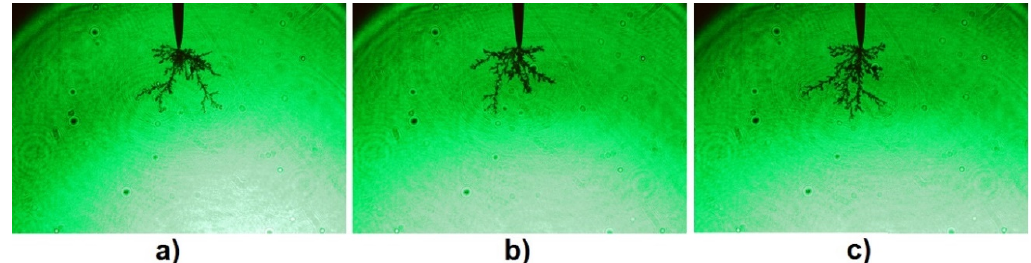
Figure 5. Photographs of negative streamers in: ( a ) synthetic ester, ( b ) natural ester, ( c ) mineral oil; d = 20 mm, V = 65kV.